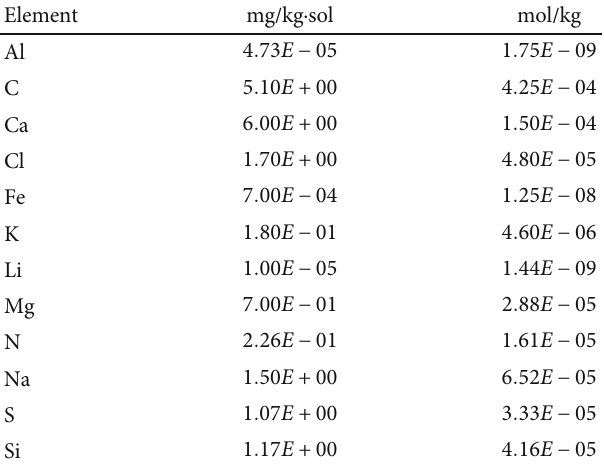
Table 2: Elemental composition of the initial aqueous solution for T = 12 ° C , pH = 6 : 80 , and Eh = 837mV . Element mg/kg · sol